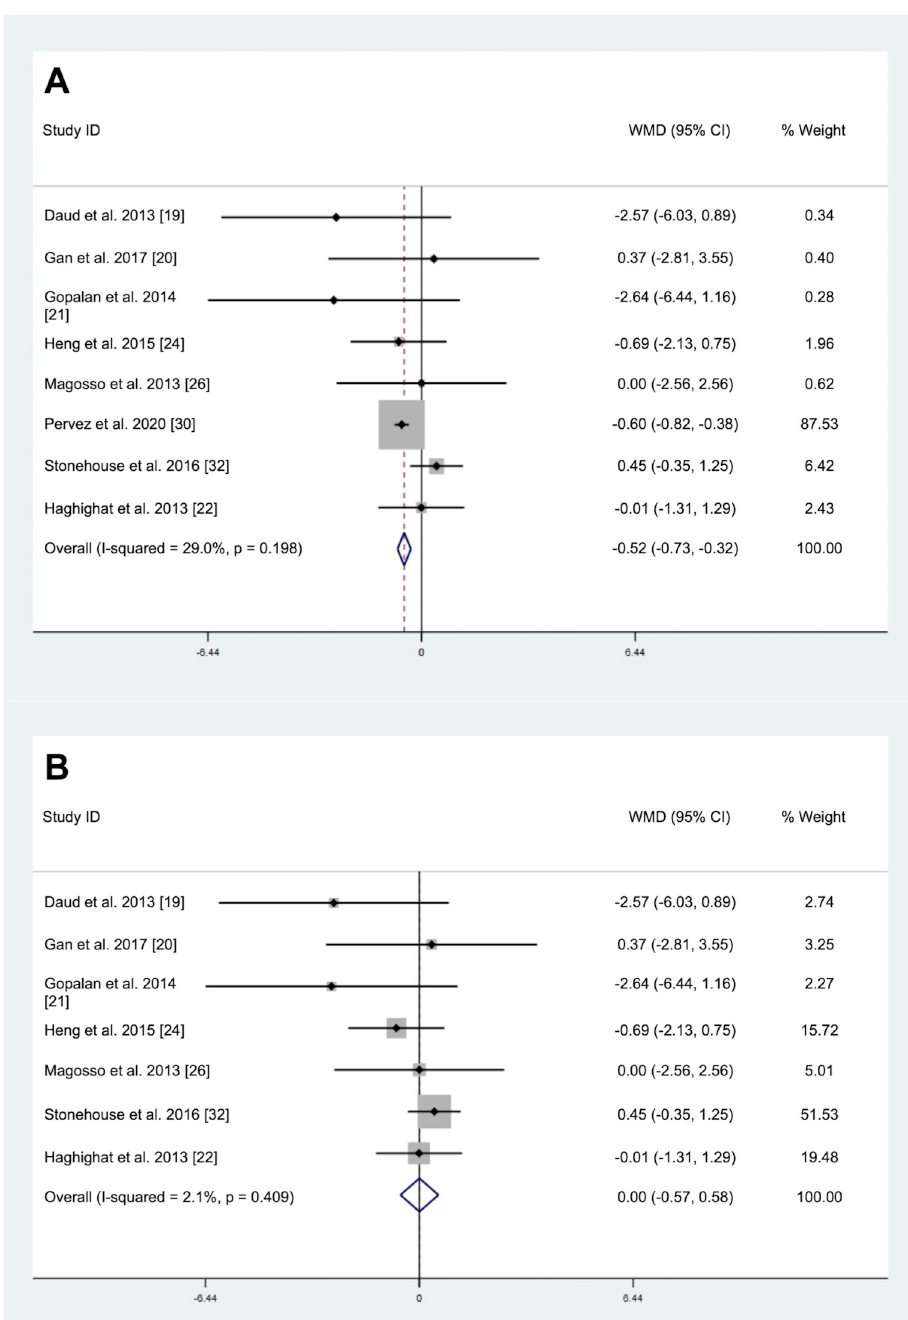
Fig 2. Forrest plot on the effect of tocotrienols supplementation on C-reactive protein levels for (A) analysis with all studies (B) analysis excluding Pervez et al. [30]. supplementation (WMD: -0.52 mg/L, 95% CI: -0.73, -0.32, p < 0.001, Fig 2) using the fixed- effect model as no significant heterogeneity was observed ( I 2 test = 29.0%, p = 0.196). Visual inspection of the funnel plot (S1 Fig), Egger’s test ( p = 0.743), and Begg’s test ( p = 0.458)